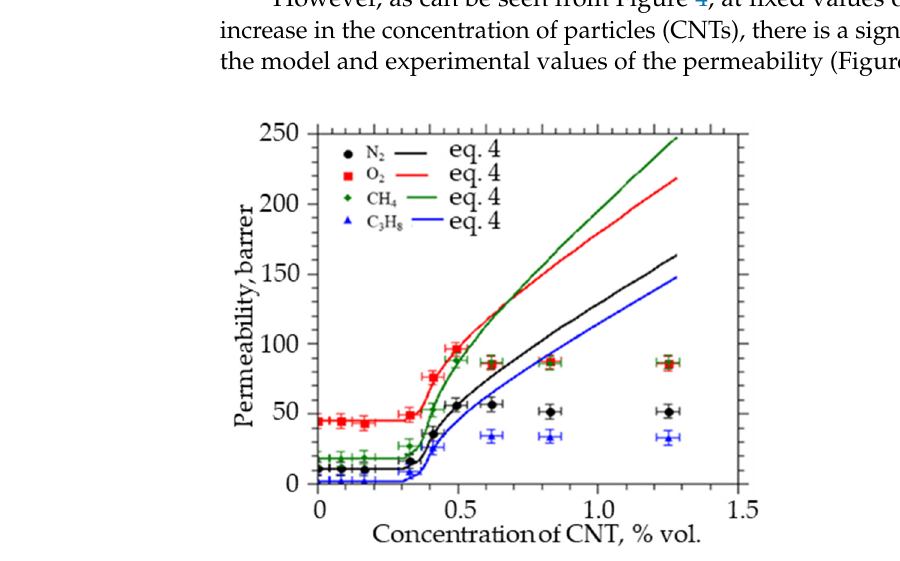
Figure 4. Permeability coefficients of nitrogen, oxygen, methane, and propane through PVTMS/CNTs membranes.